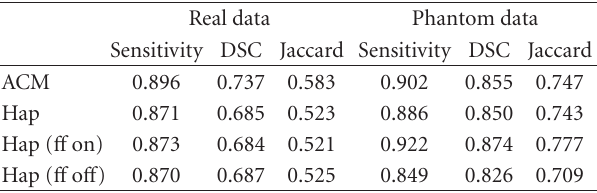
Table 1: Statistics of segmentation